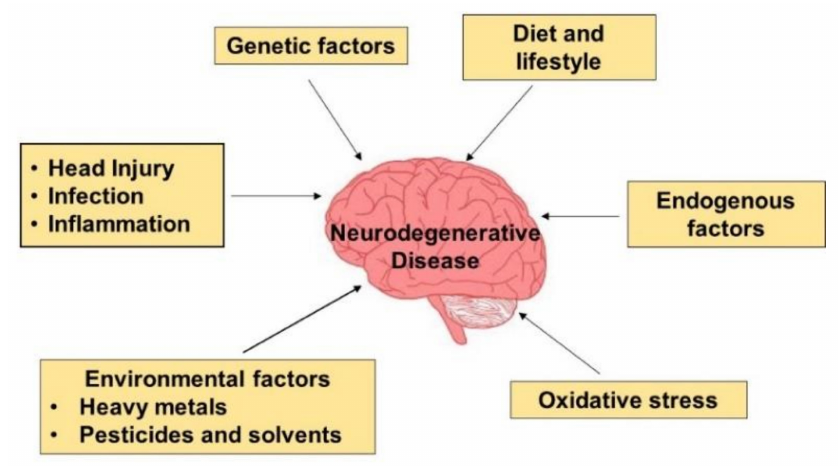
Figure 1. Etiology of neurodegenerative diseases. In most neurodegenerative diseases, the onset of the disease is unknown. Environmental, genetic, and endogenous factors and oxidative stress must be considered when investigating the mechanism of the onset of